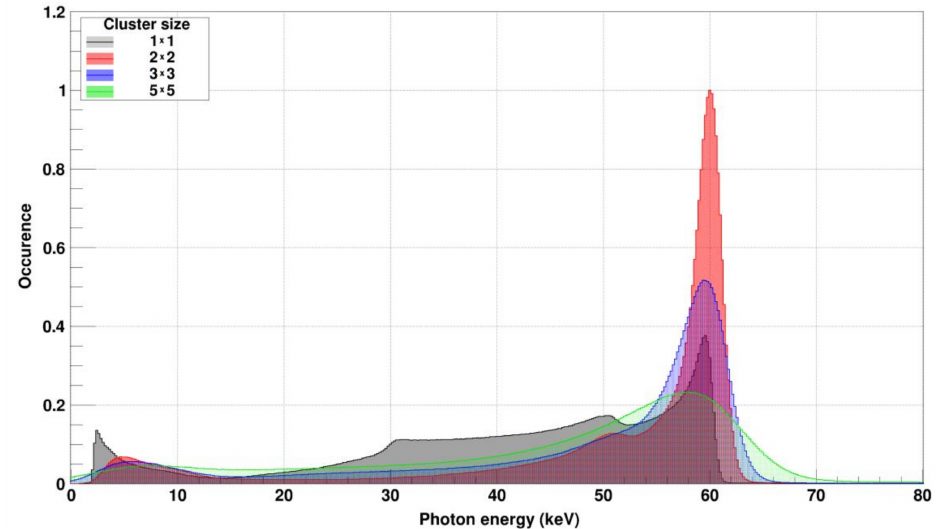
Figure 5. Energy spectrum of 60 keV monochromatic photons measured with a GaAs:Cr sensor (2017) bump bonded to a JUNGFRAU readout chip. A cluster finder was used to identify photons and to center the cluster around the pixel with the highest signal. The gray spectrum uses only the information from the cen-tral pixel of the cluster (1 × 1), e.g., the pixel with the highest signal. Escape photons as well as a relatively high charge sharing tail are visible. The red spectrum is composed of the four pixels of the pixel cluster with the highest summed signal (2 × 2 cluster). In this case, the FWHM for the whole pixel matrix is 2.58 keV or 4.3%. The blue spectrum uses the summed signal from the central pixel plus its eight neighbors (3 × 3 clus-ter), the green spectrum the information from a 5 × 5 pixel cluster centered around the pixel with the highest signal. (The increase of the photo peak width with bigger clusters is due to the higher number of pixels and thus their summed up noise contributions using